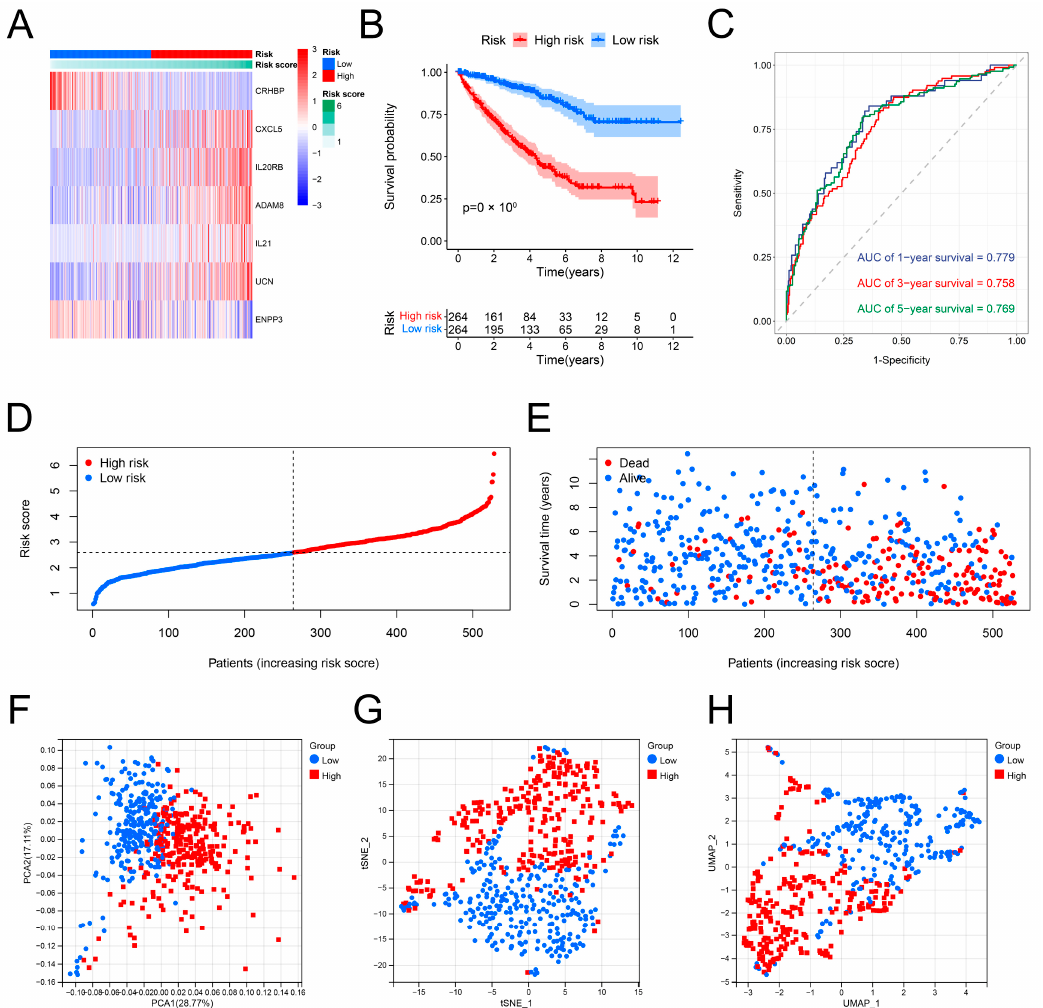
Figure 5. Predictive performance of the IRRS in the TCGA dataset. ( A ) Expression distribution of seven selected genes. ( B ) The difference in OS between the groups with high and low risk. ( C ) ROC curves of the IRRS for 1-, 3-, and 5-year OS prediction. ( D , E ) Distribution of ccRCC specimens with varying risk scores, survival times, and survival statuses. ( F – H ) Distribution of ccRCC specimens in the two risk groups was examined using PCA, t-SNE, and UMAP.